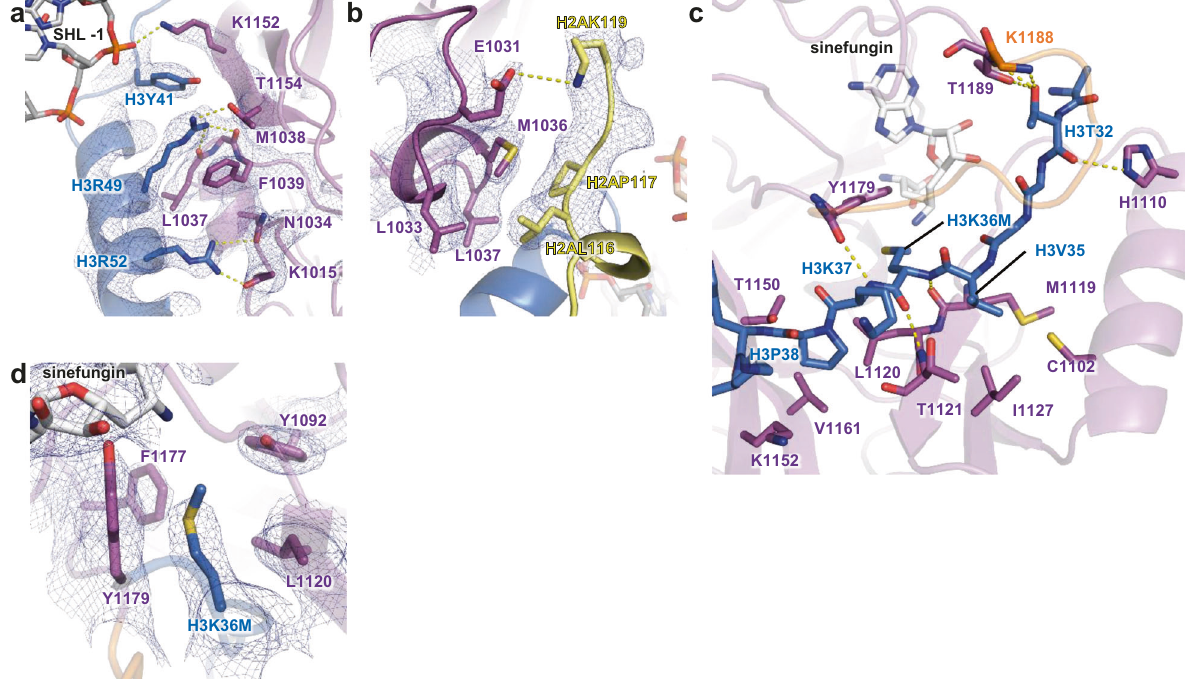
Fig. 2 Interactions of NSD2 with histones H3 and H2A and DNA. The cryo-EM density is shown as a blue mesh in a (contoured at 7 σ ), b (at 3 σ ), and d (at 5 σ ). a Interactions with the fi rst α -helix of H3 and DNA. b Interactions with H2A. c Interactions with the H3 tail region. d The H3K36-binding